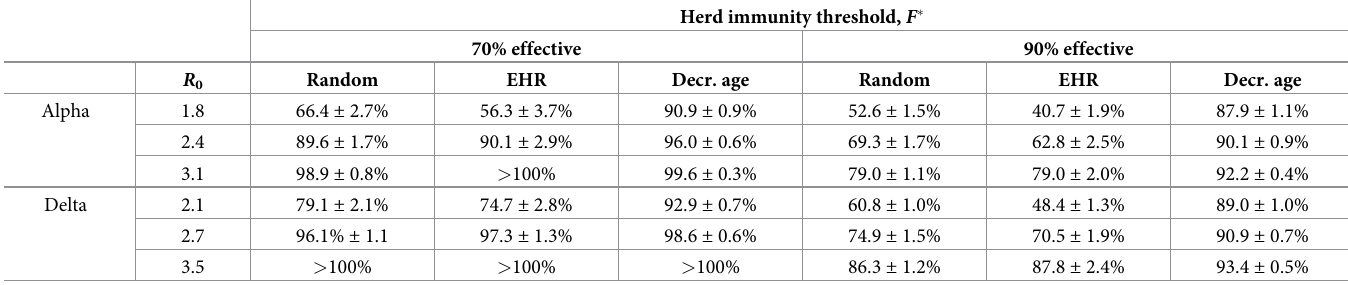
Table 2. Herd immunity thresholds F � in response to R 0 and choice of strategy according to strain. Fraction of population requiring vaccination in order to reach herd immunity ( R < 1) according to each strategy and R 0 for an unvaccinated population. Each data point (mean R and standard error) is based on 20